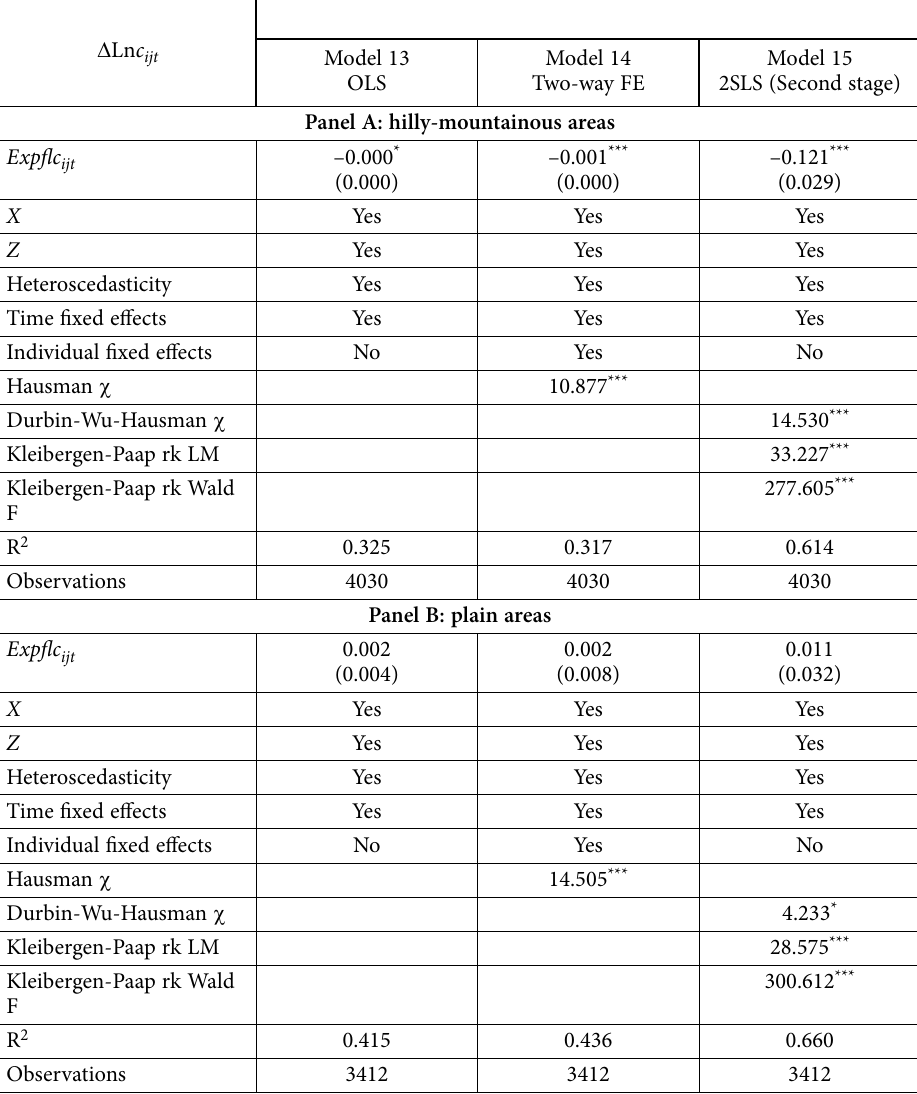
Table 8. Estimation results of terrain